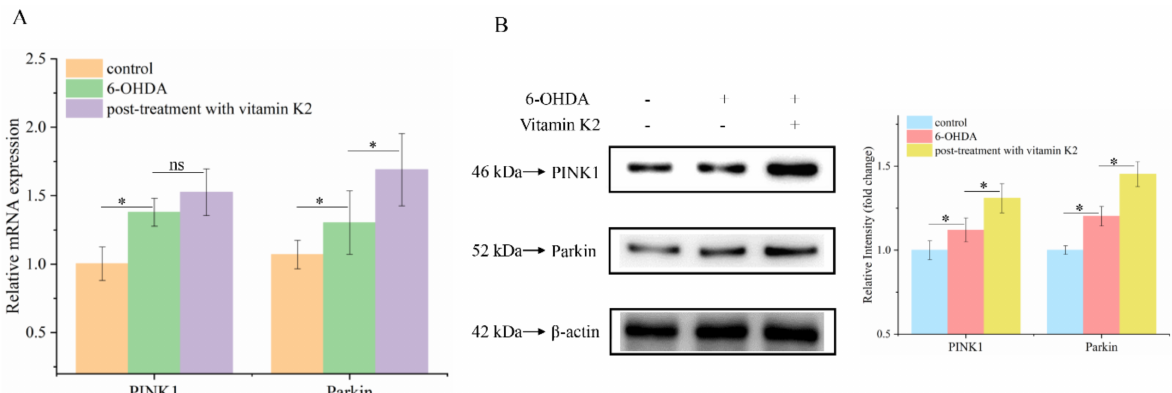
Figure 7. PINK1/Parkin signaling pathway was involved in the regulation of mitophagy by vitamin K2. ( A ) Measurement of PINK1 and Parkin mRNA expression changes by RT-qPCR. ( B ) Changes in protein expression levels of PINK1 and Parkin detected by Western blot; images were quantified by using the ImageJ software. The data are presented as mean ± SD ( n = 3). Significant difference * p < 0.5 vs. control. (ns: no